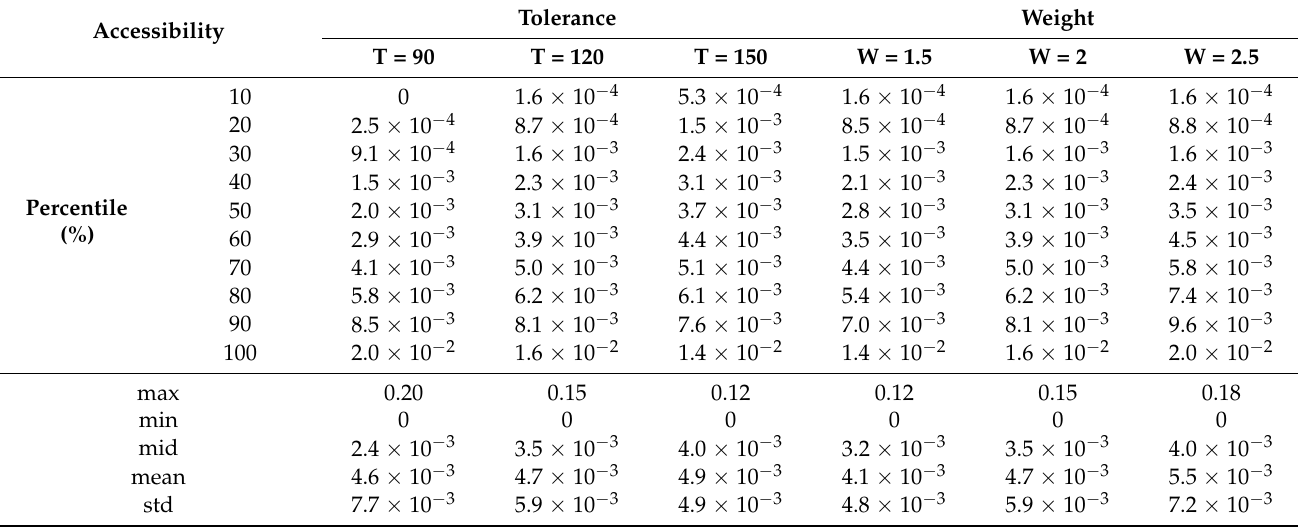
Table 4. Sensitivity